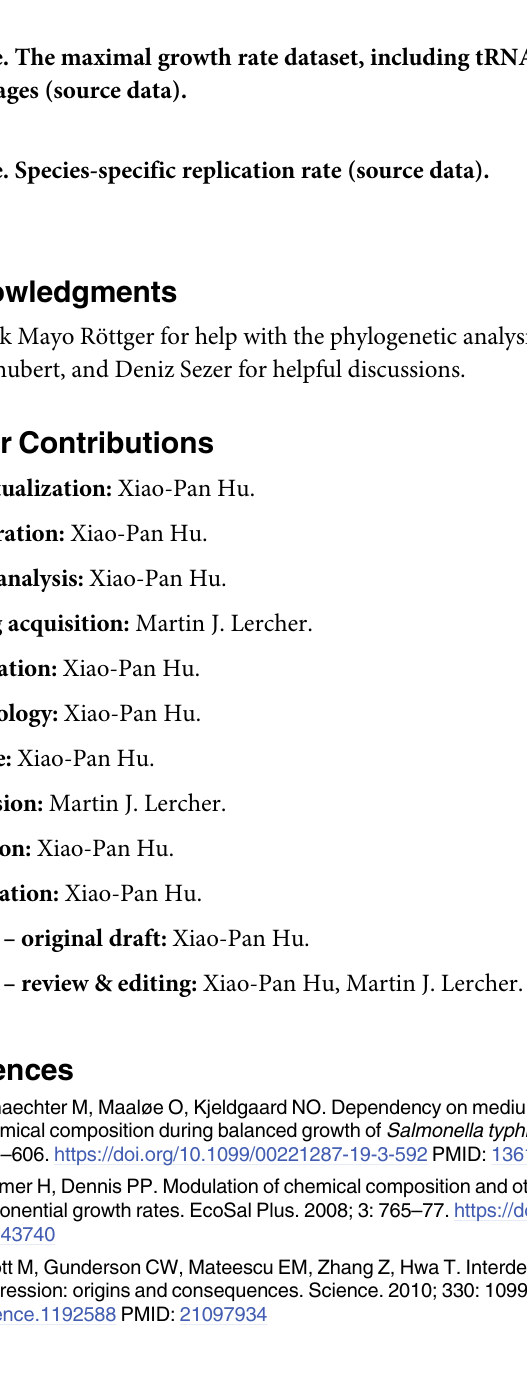
S1 Table. Ternary complex per ribosome in E . coli (source data). S2 Table. tRNA per rRNA in other species (source data). S3 Table. Fitted ribosome turnover number ( k ) by Eq (1) and effective ribosome turn- cat over number ( k ) for species in Fig 2 (source data). eff S4 Table. The maximal growth rate dataset, including tRNA and rRNA positions, copies, and dosages (source data). S5 Table. Species-specific replication rate (source data).